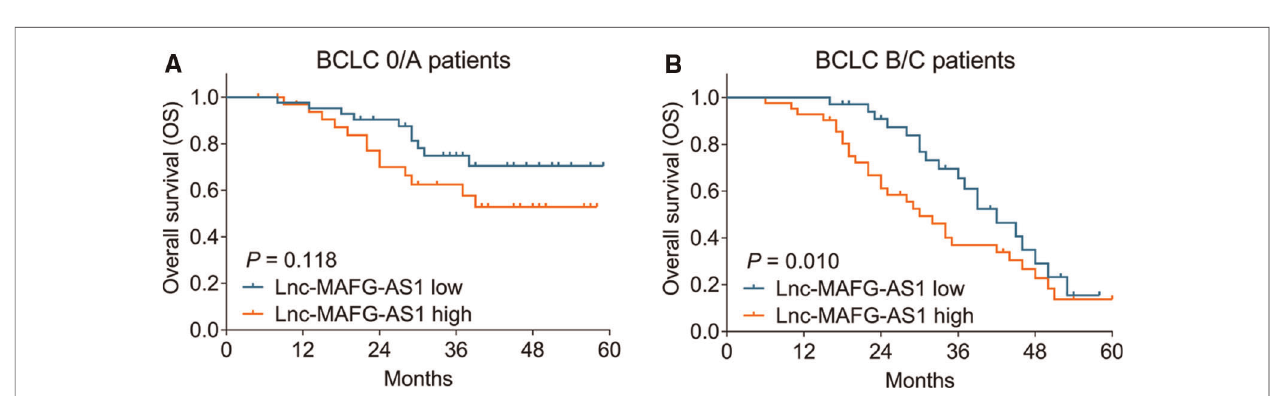
FIGURE 4 | Subgroup analysis. Correlation of lnc-MAFG-AS1 expression with OS in the Barcelona Clinic Liver Cancer (BCLC) 0/A subgroup ( A ) and BCLC B/C subgroup ( B ).